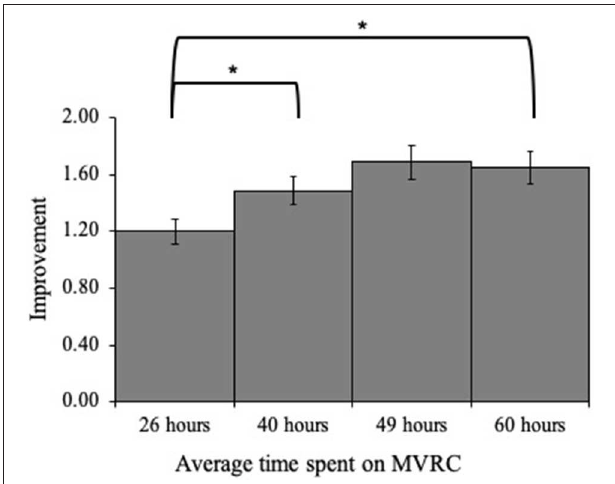
FIGURE 6 | Average improvement of 6th-grade reading fluency, as a function of hours practiced (separated into quartiles). Error bars represent standard errors. *Significant difference obtained with Bonferroni pair-wise comparisons ( p < 0.05).